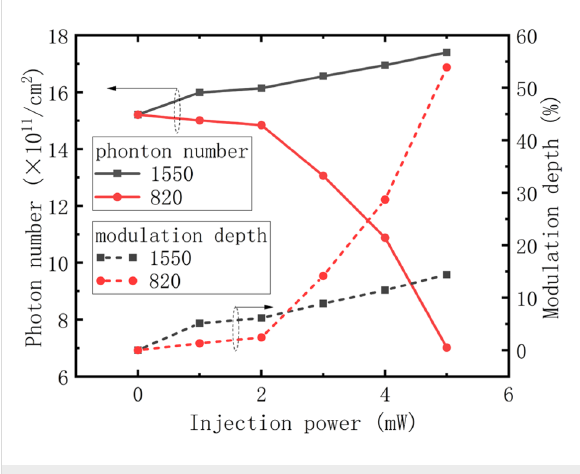
Figure 7: Modulation depth and photon number vs optical injection power at two